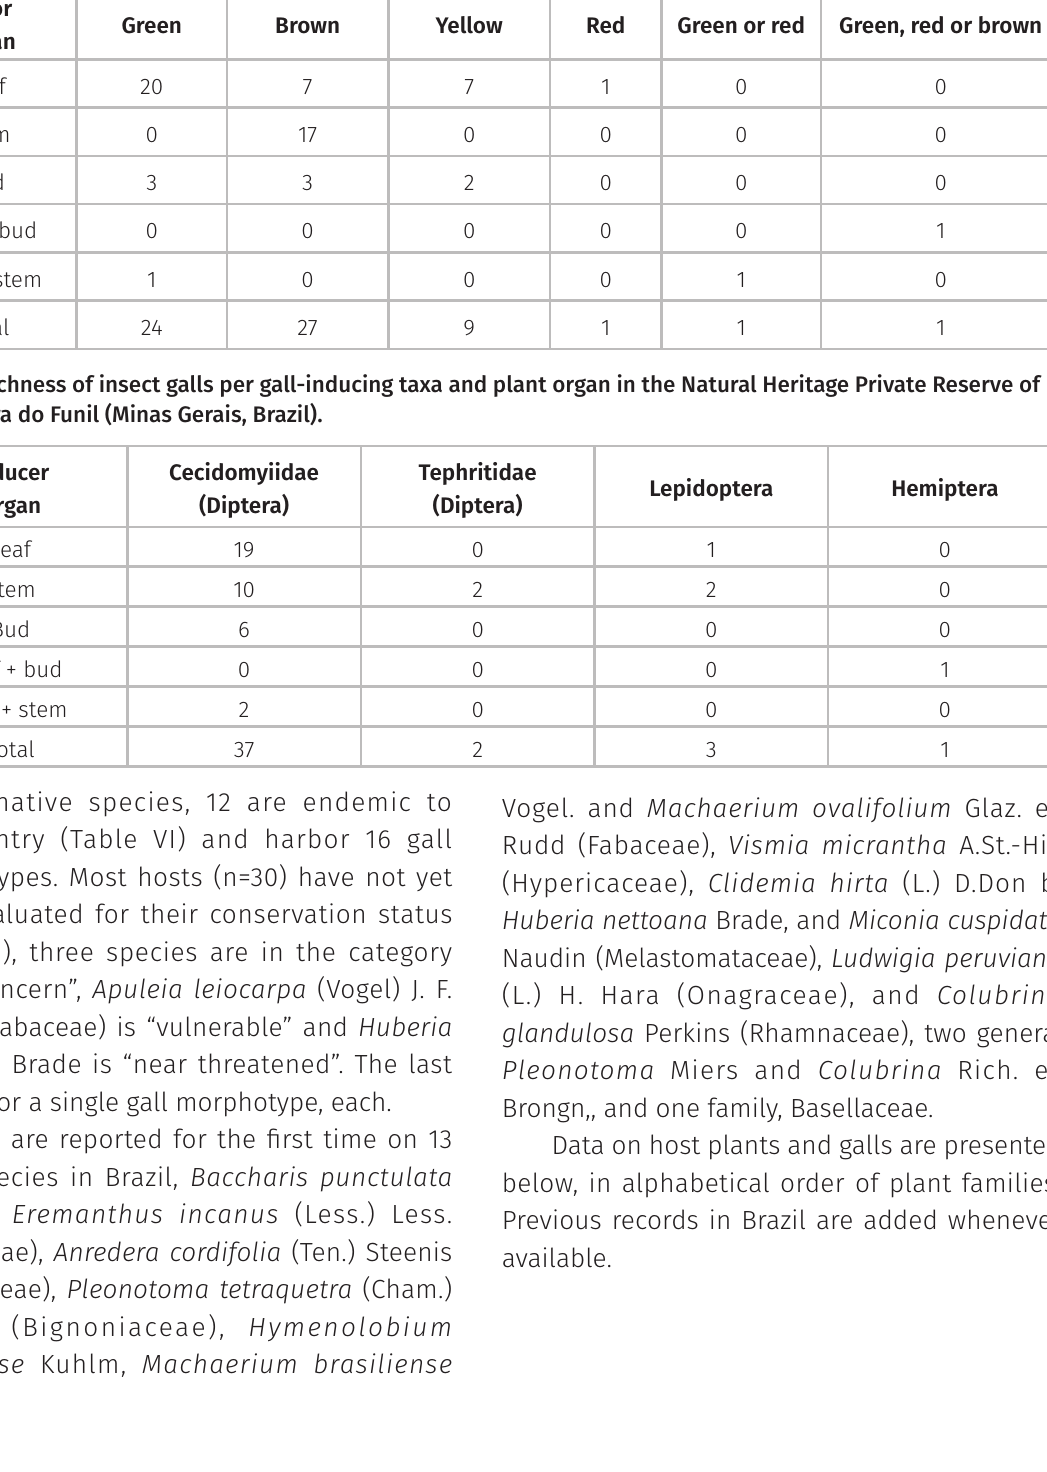
Table IV. Richness of insect galls per plant organ and color in the Natural Heritage Private Reserve of Serra Negra do Funil (Minas Gerais, Brazil).